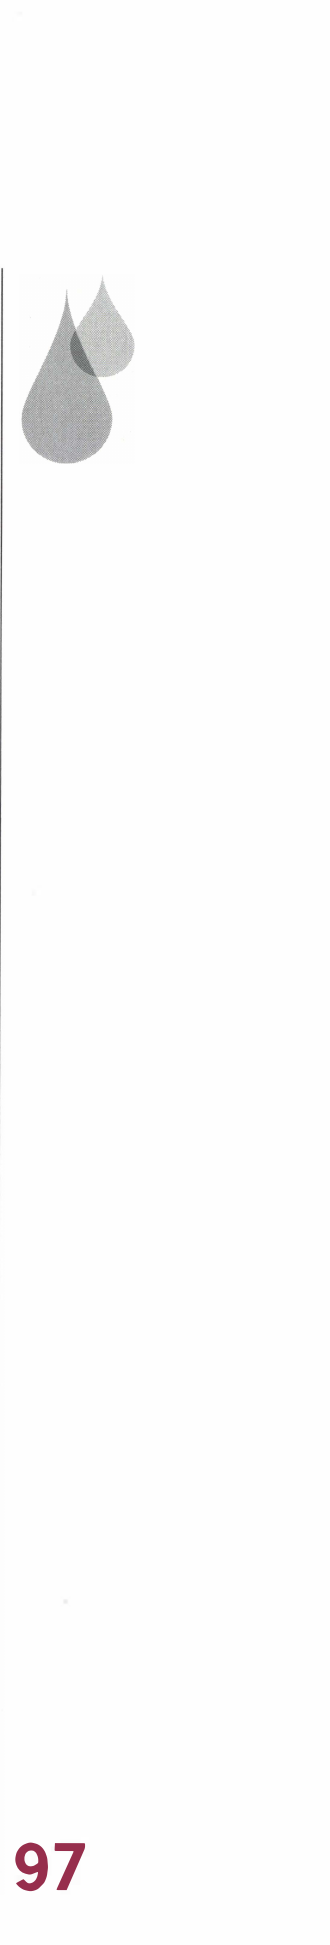
Fig. 1: Simplified representation of the viscosity profile during dilution of organic and water-soluble